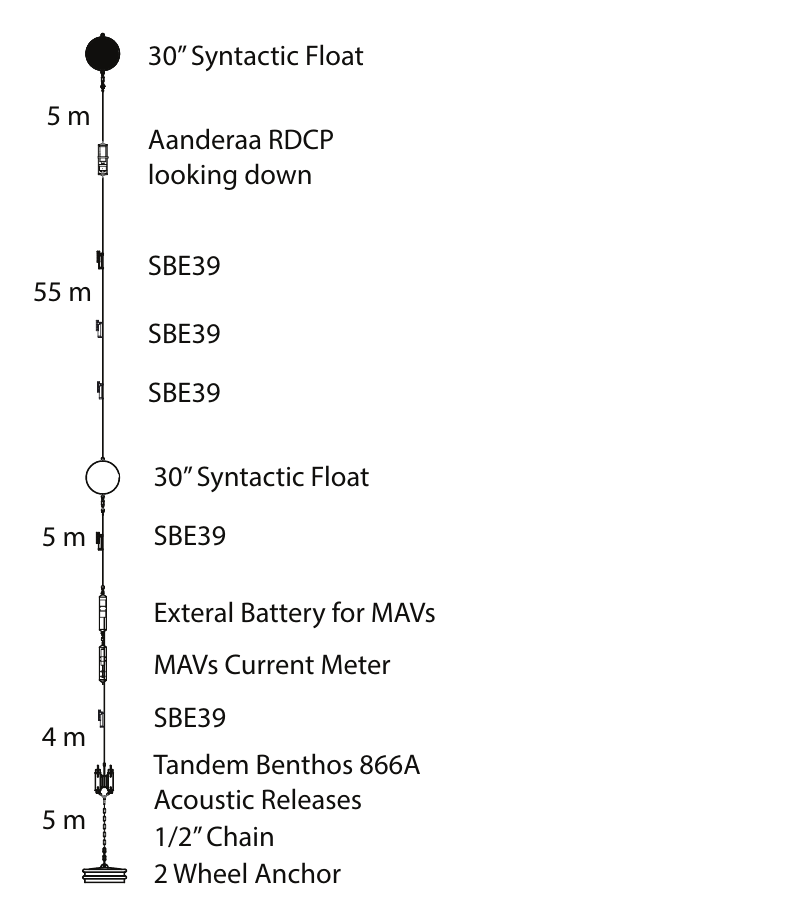
Figure 3. Schematic of the deep